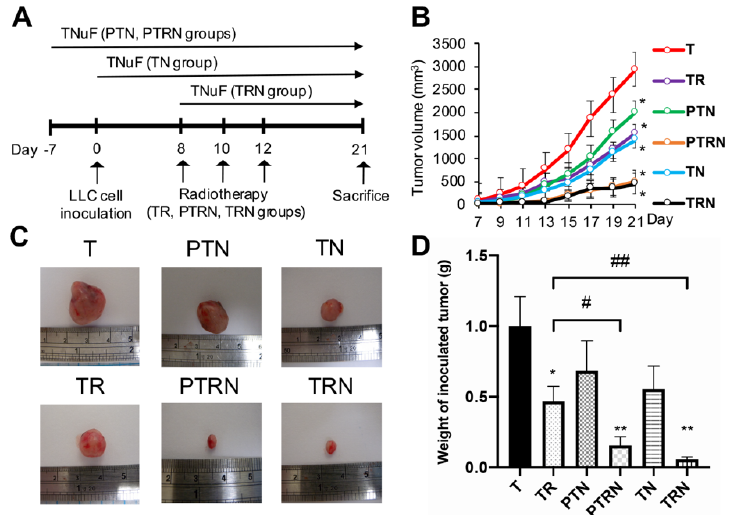
Figure 1. Total nutrition formula enhances anticancer effect and inhibits cell proliferation in tumors receiving radiotherapy. ( A ) Each group of mice was composed of six male C57BL / 6JNarl mice. Here, 3 × 10 5 Lewis lung carcinoma (LLC) cells were inoculated into the right posterior flank region of C57BL / 6JNarl mice on Day 0, except for mice of the C group, which received subcutaneous injection of normal saline instead. The TNuF total nutrition formula, 1 g / mice / day, was prescribed orally (PO) from Day -7 in the PTN and PTNR groups, from Day 0 in the TN group, and from Day 8 in the TRN group. In contrast, mice of the C, T, and TR groups were fed with regular rodent diet. In the TR, PTRN, and TRN groups, mice received external beam radiation (RT) to the right posterior flank tumor at 300 cGy / fraction, one fraction per day on Days 8, 10, and 12. All mice were sacrificed on day 21. ( B ) Tumor volume growth curve of various treatment ( n = 6). ( C ) Representative inoculated tumors at sacrifice. ( D ) The inoculated tumor weight of each group measured at sacrifice ( n = 6). Data are expressed as means ± SD. *, p < 0.05 as compared to the T group. **, p < 0.01 as compared to the T group. #, p < 0.05 as compared to the TR group. ##, p < 0.01 as compared to the TR